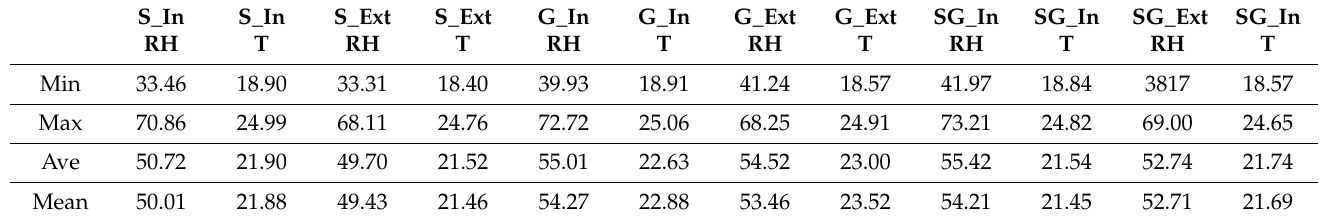
Figure 7. Comparison of annual cooling, heating, and dehumidification demand for gypsum and Table 6. In-Situ measurements of relative humidity (RH) and temperature (T) on the interior (In)